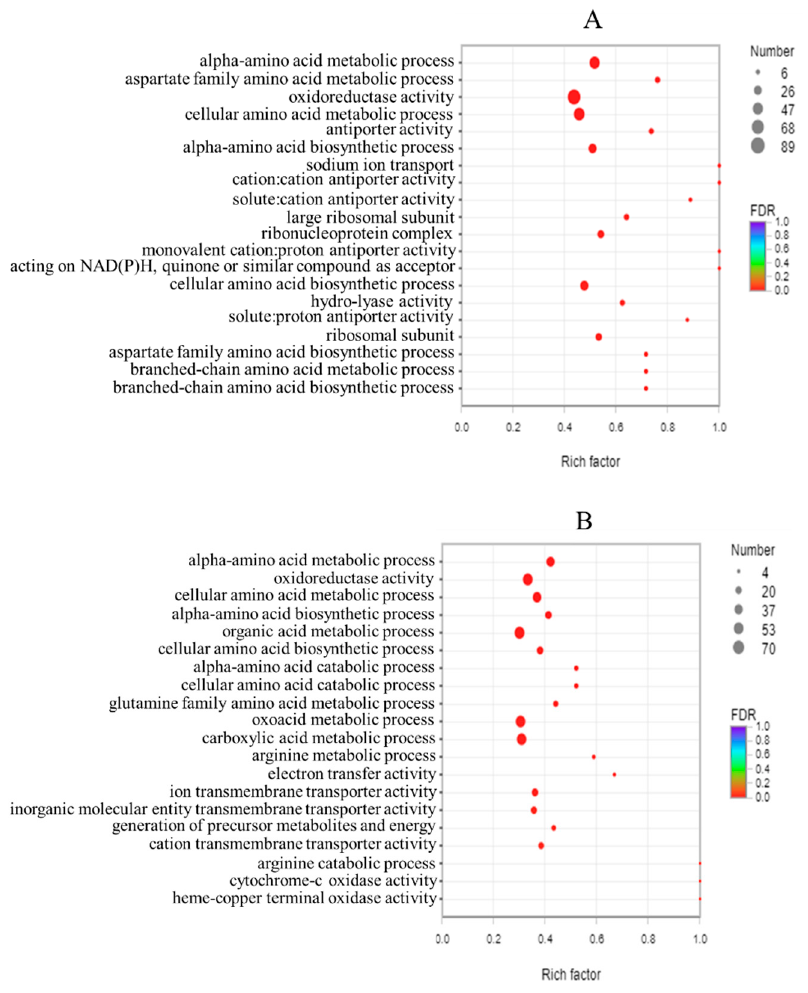
Figure 7. Scatter plots of the top 20 enriched GO terms for DEGs in BB-11 ( A ) and BA-26 ( B ). The vertical axis represents the GO term, and the horizontal axis represents the enrichment factor. The size of the dot indicates the number of genes/transcripts enriched in this GO term, and the color of the dot corresponds to different FDR ranges.